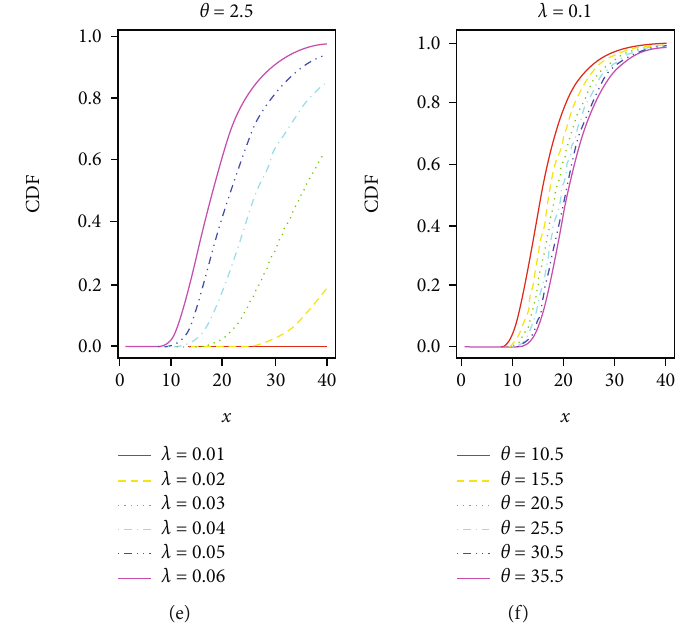
Figure 1: PDF and CDF plots of IRE distribution for di ff erent values of